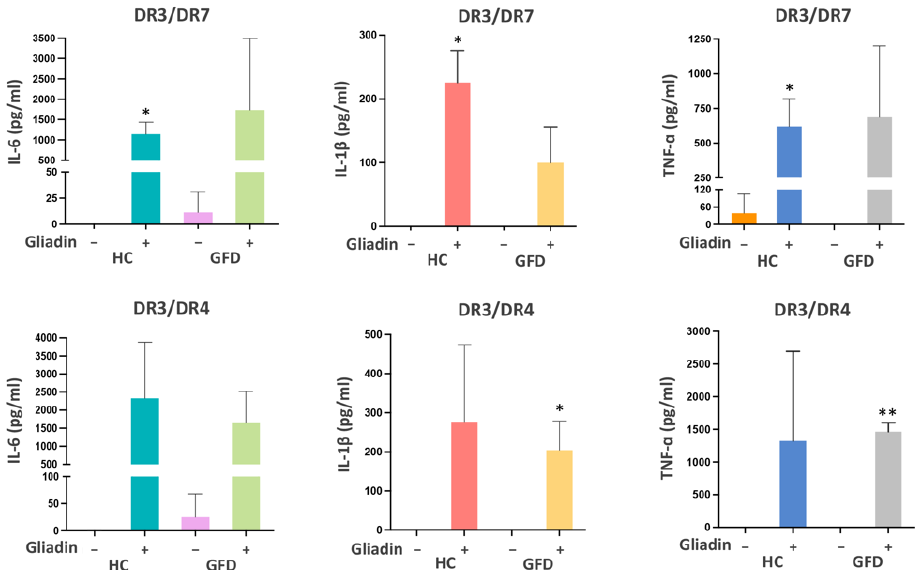
Figure 1. Proinflammatory cytokines production after gliadin stimulation. Quantification of proin- flammatory cytokines on supernatants of macrophages after overnight gliadin stimulation in healthy controls (HC) ( n = 3: FFL340, FFL665, and FFL329) and CD patients following a gluten-free diet (GFD) (n = 3: CHM144A, CHM150A, and CHM019A) carrying DR3/DR7 genotype and in HC ( n = 3: FFL605, FFL642, and FFL1119) and GFD patients ( n = 3: CHM13C, CHM88A, and FFL639) with DR3/DR4 genotype (* p < 0.05, ** p < 0.01).